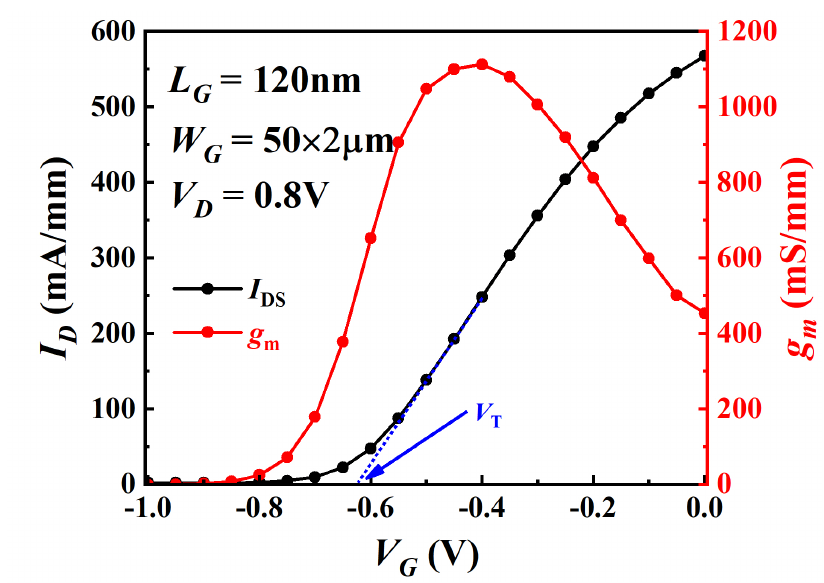
Figure 6. Transfer characteristics of the InGaAs HEMTs on Si substrates.